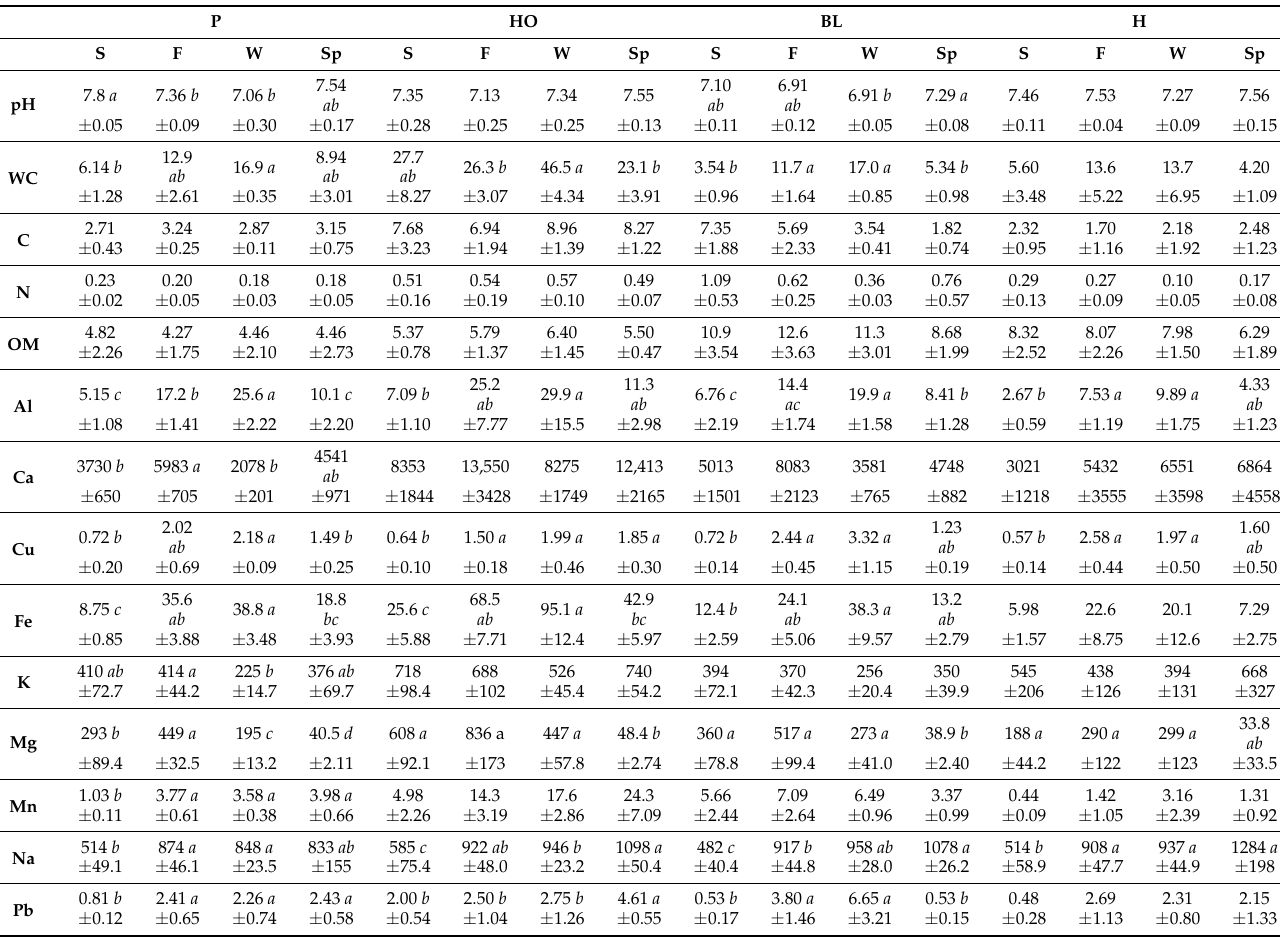
Table 2. Abiotic properties of soils under different vegetation covers in each season. Mean values ( n = 6, ± s.e.) of pH, water content (WC, expressed as % d.w), C and N concentrations (expressed as % d.w.), organic matter content (OM, expressed as % d.w.), and Al, Ca, Cu, Fe, K, Mg, Mn, Na, and Pb available fractions (expressed as µ g g − 1 d.w.) in soils collected inside the Vesuvius National Park under different vegetation covers (P: pine; HO: holm oak; BL: black locust; H: herbs) and seasons (S: summer 2018; F: fall 2018; W: winter 2019; Sp: spring 2019). Different letters indicate statistically significant differences among seasons in each property of soils collected under the same vegetation cover (ANOVA test, at least, p <